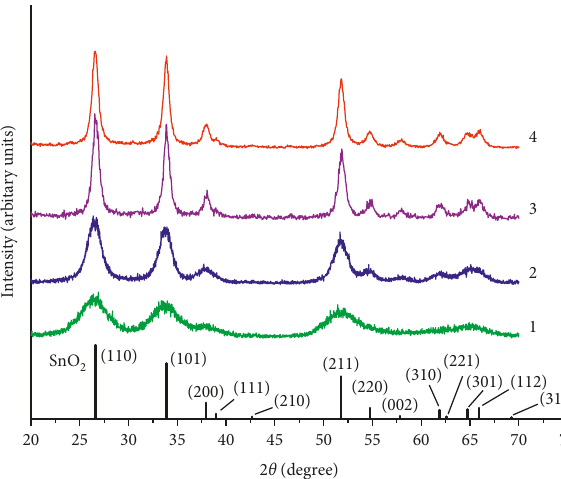
Figure 2: XRD data for xerogel (1); material obtained through temperature treatment of xerogel at 400 ° C during 2 hours 20minutes (2); undoped sensor material (3); sensor material doped with 0.24 wt.% Pd (4).